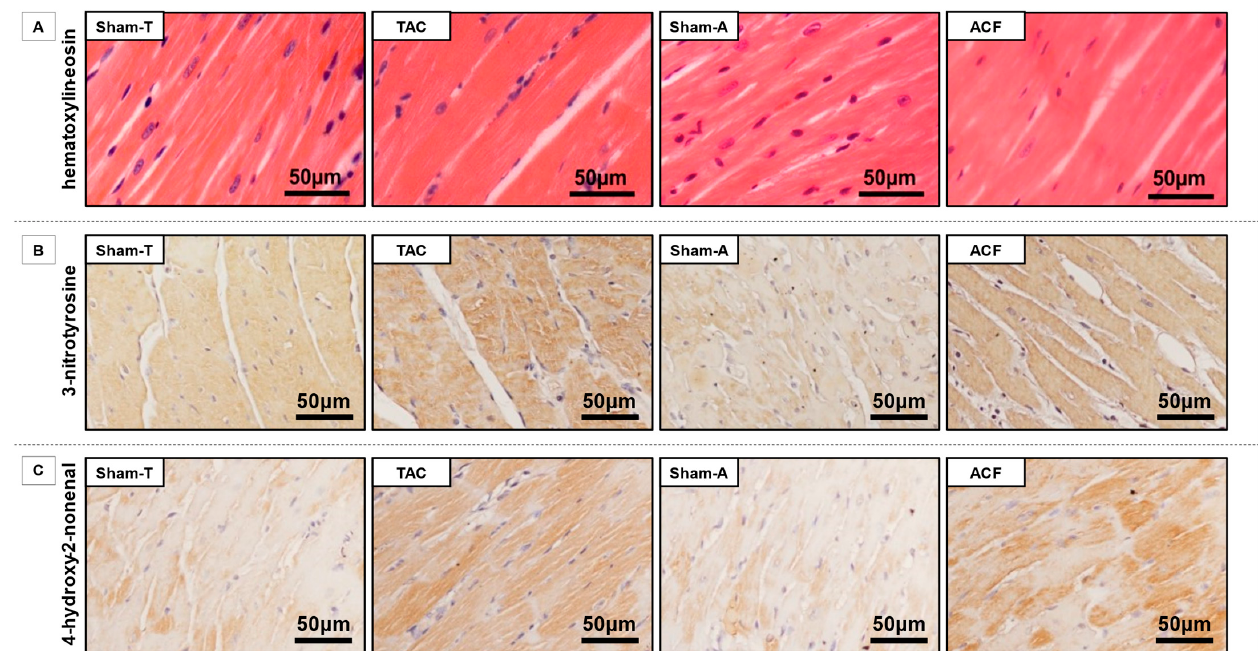
Figure 4. Histological sections from sham-operated and hemodynamically-overloaded hearts. ( A ) Representative LV sections of Sham-T, TAC, Sham-A, and ACF hearts stained with hematoxylin-eosin. ( B ) Representative LV sections of Sham-T, TAC, Sham-A, and ACF hearts with immunohistochemical staining against 3-nitrotyrosine (3-NT), a marker of nitrosative stress. Hematoxylin was used to stain nuclei. Images were captured with 20 × objective, scale bars are shown for reference on each representative section. ( C ) Representative LV sections of Sham-T, TAC, Sham-A, and ACF hearts with immunohistochemical staining against 4-hydroxy-2-nonenal (4-HNE), a marker of oxidative stress. Hematoxylin was used to stain nuclei. Images were captured with 20x objective, scale bars are shown for reference on each representative section.